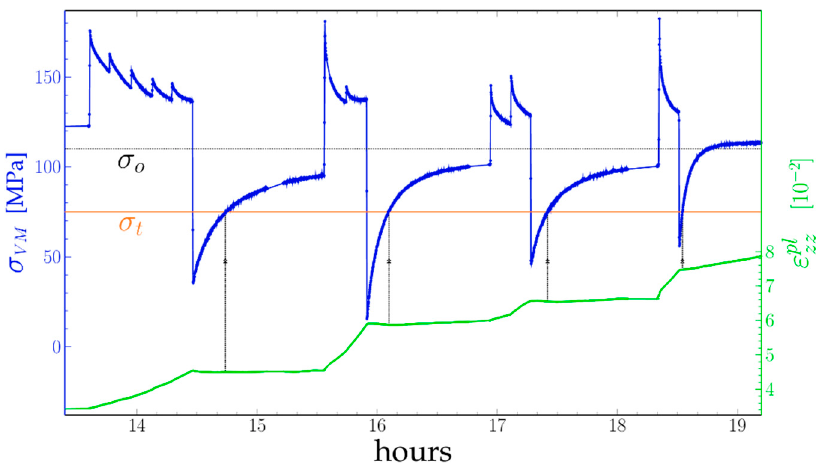
Figure 8. Creep test of the AM1 sample with short period at 970 ◦ C σ VM stress (blue), expected Orowan stress σ O (black), apparent threshold stress σ t (orange) and plastic strain ε pl zz in